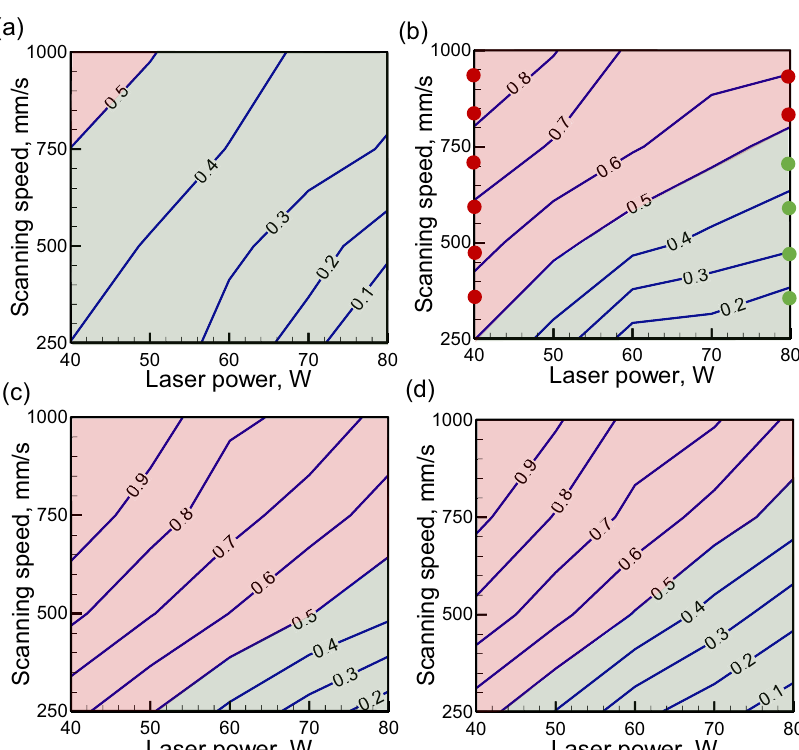
Fig. 6 Lack of fusion susceptibility maps. Lack of fusion susceptibility maps of different alloys, ( a ) AlSi10Mg, ( b ) Ti6Al4V, ( c ) SS316, and ( d ) IN 718. The red zones indicate a lack of fusion susceptible zones, and the green zones are safe regions. The values on the lines represent the values of LFI . The beam radius was 50 μ m, the layer thickness was 30 μ m, and the hatch spacing is 100 μ m. The red dots and green squares are data points taken from the literature 13 for validation. The green circles correspond to the cases without lack of fusion and the red cycles indicate the cases where voids were found.